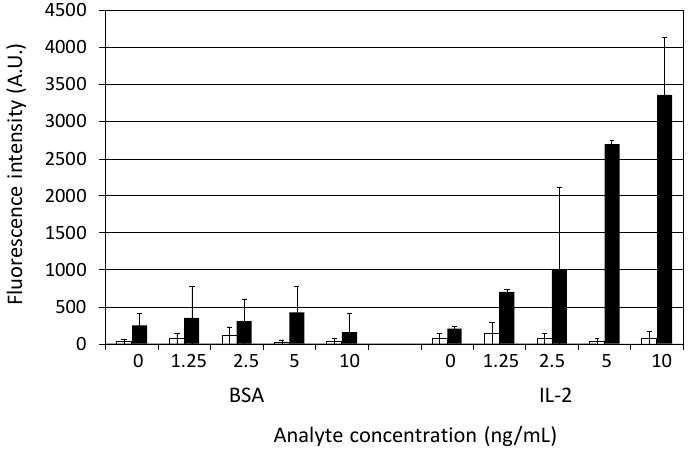
Figure 6. Sandwich immunoassay targeting IL-2 detected by using Cy3-labeled streptavidin on the unmodified (white bars) or multilayered (black bars) microplate. Error bars indicate the standard deviation of three measurements.